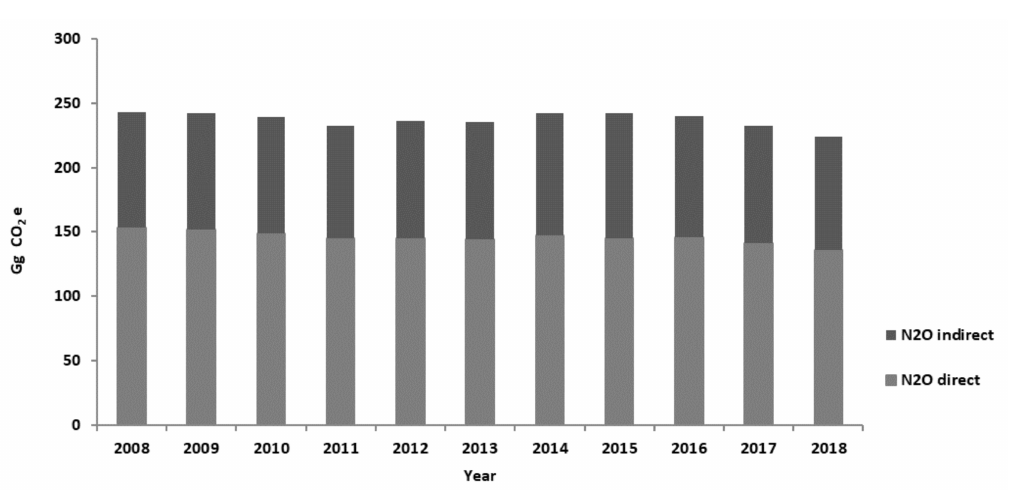
Figure 6. Evolution of direct and indirect N 2 O emissions (Gg CO 2 e) from Tunisian livestock during the studied period